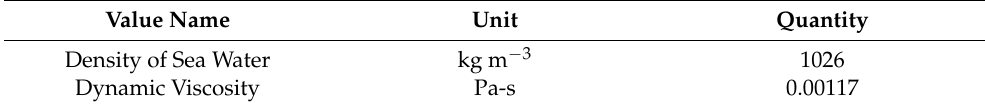
Table A1. Properties of sea water [67].